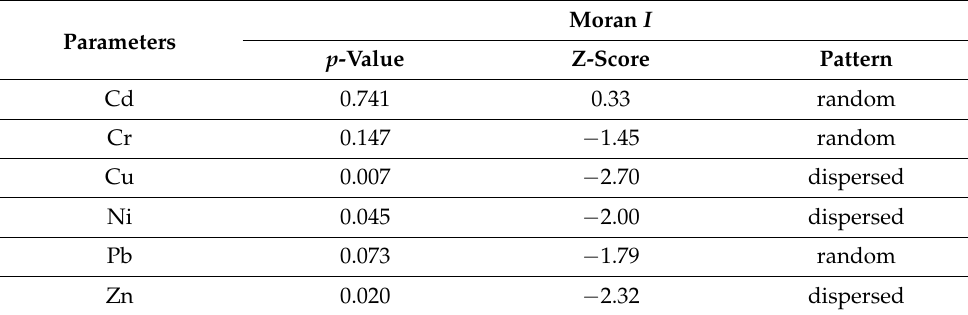
Table 3. Results of autocorrelation analysis based on Moran’s I